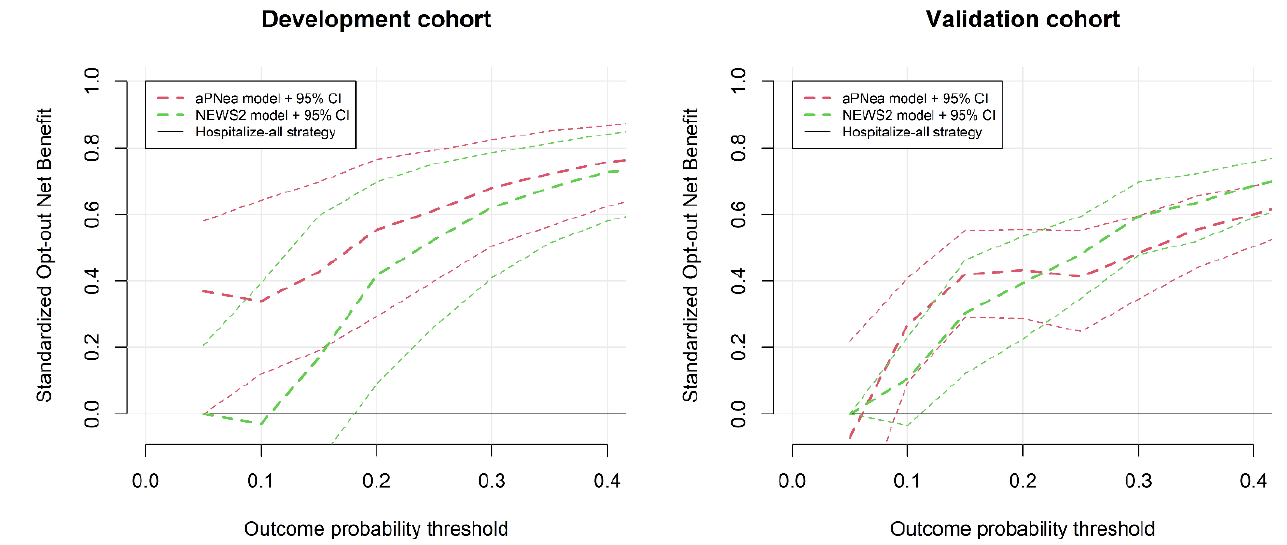
Figure 3. Decision curves for the development and validation cohorts presenting the standardized opt-out net benefit with the 95% confidence interval by increasing the outcome probability threshold for each score model compared to a “hospitalize-all” strategy of zero net benefit.